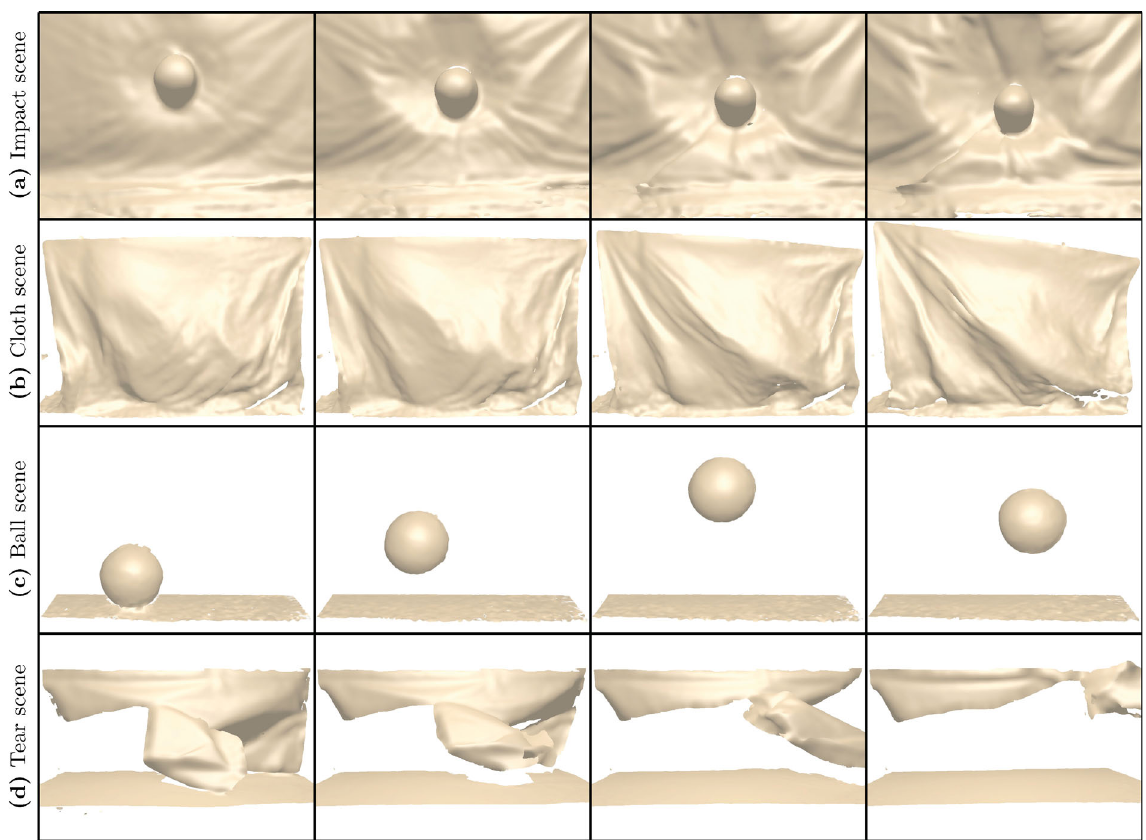
Fig. 9 Reconstructing highly dynamic scenes: (a) a ball is thrown at a cloth curtain; (b) a cloth is shaken; (c) a ball bounces off the ground; and (d) a large piece of paper is torn apart.